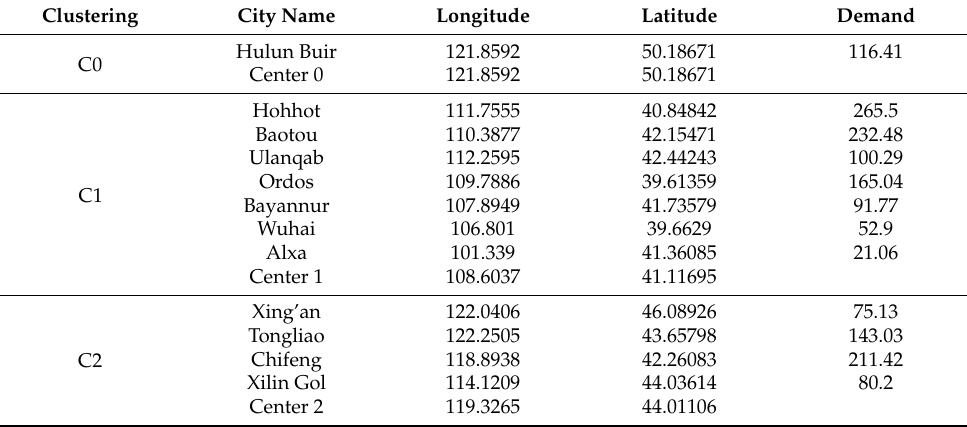
Table 7. The location results for the GCM. Clustering City